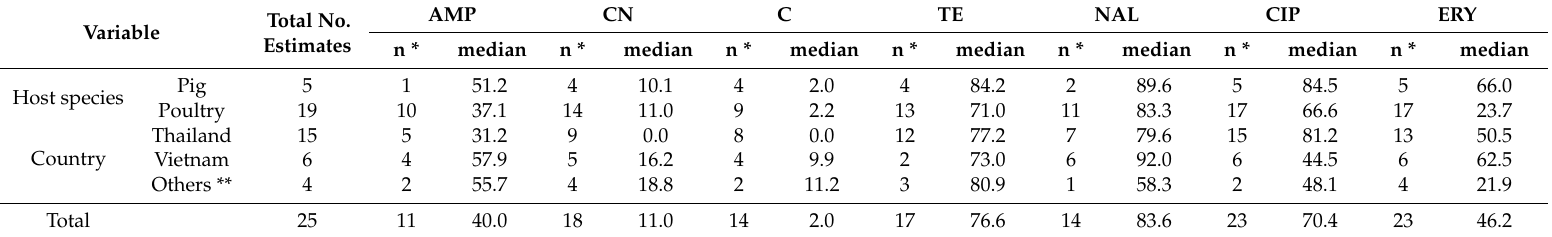
Table 2. Summary of prevalence estimates (N = 25) of resistance against antimicrobials tested among Campylobacter spp. isolates from a total of 18 publications in SEA.